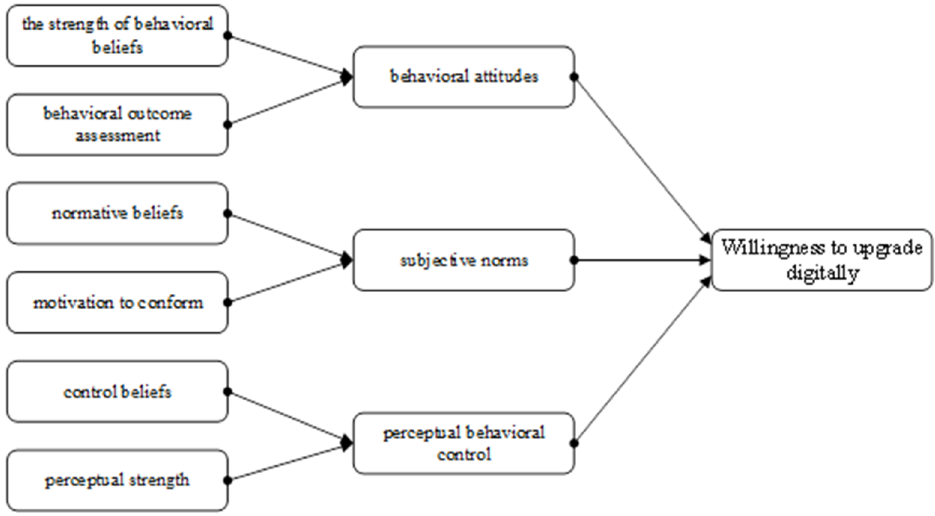
Figure 1. Hypothetical model of factors influencing willingness to digitally upgrade rural e-com- merce .